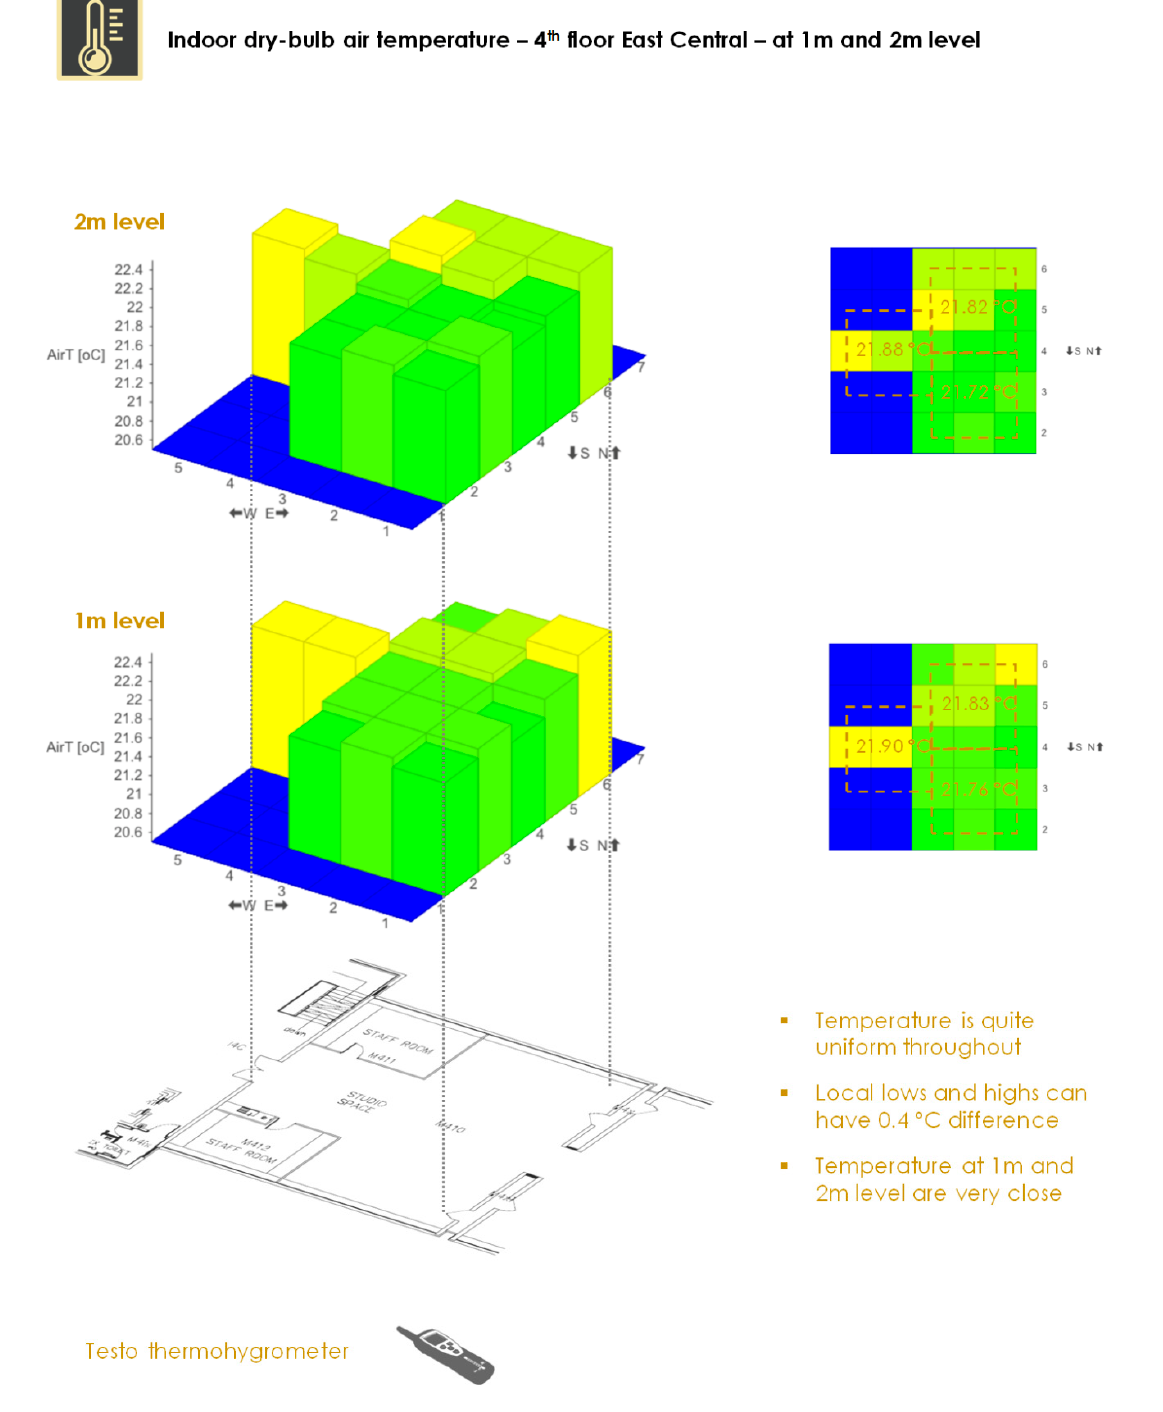
Figure A3. Variations of Indoor DBT levels at the 4th floor studio spaces (source: spot measurements plotted by the author; an icon has been used in this figure retrieved from Flaticon.com) [40].